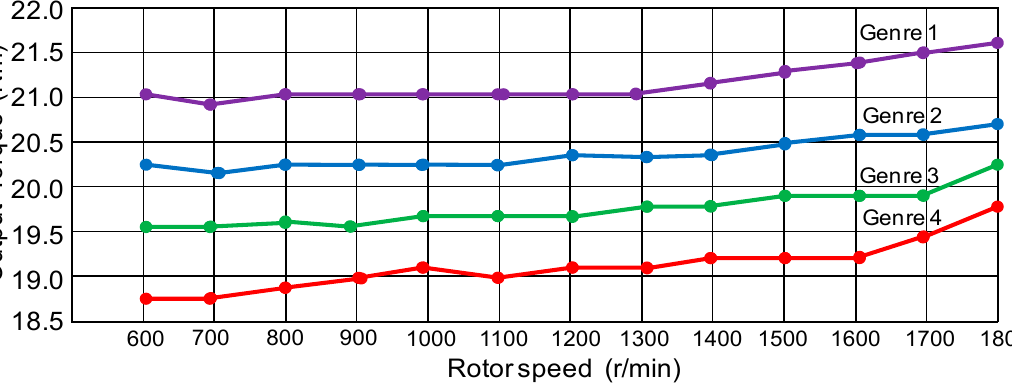
Figure 6. Line chart of comparisons of power factor for 4 kinds of six-phase synchronous reluctance motors mounted to centrifugal compressor with various speeds.